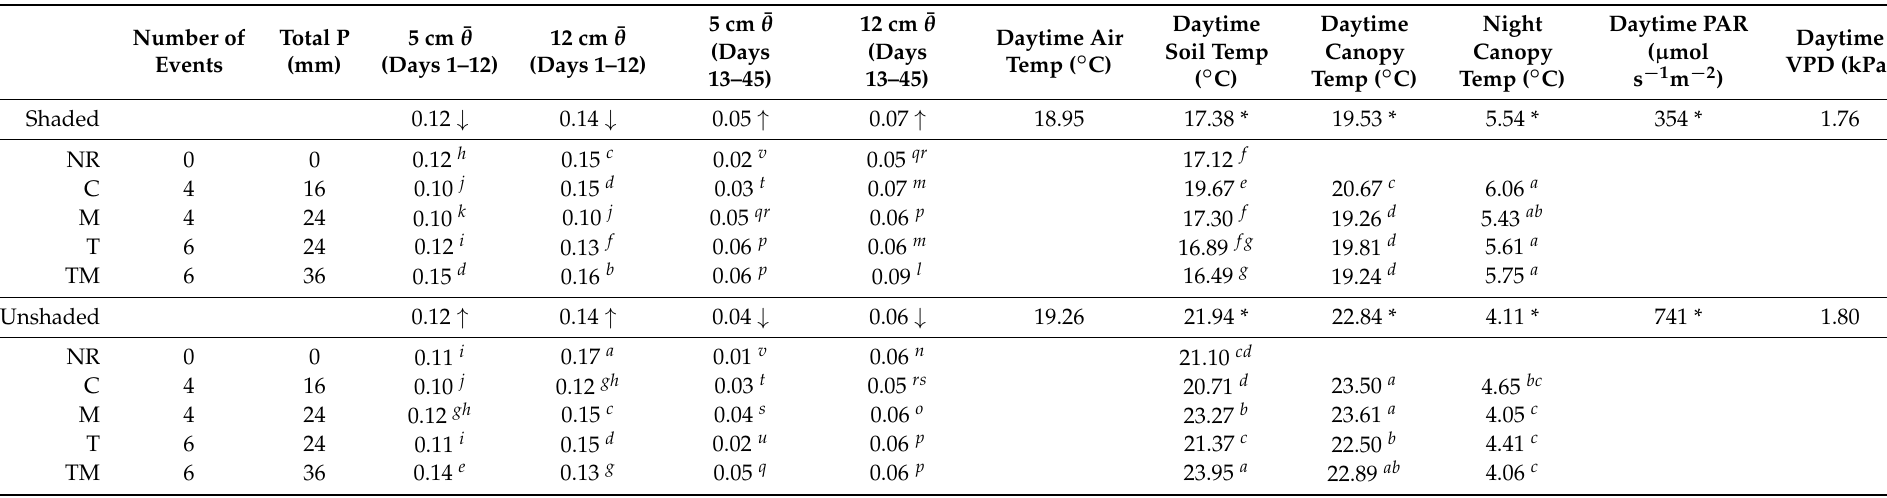
Table 1. Summary of experimental water addition treatments and environmental characteristics of treatment groups (NR: no rain, C: control, M: +50% magnitude, T: +50% timing, TM: +50% timing and magnitude) within microsites (shaded: 47% canopy cover, unshaded: 1% canopy cover). Soil moisture [VWC: mm 3 mm − 3 ] is organized between 5 cm and 12 cm depths and periods of treatment days before (days 1–12) and after (13–45) when VWC began to be depleted (see Figure 3). Because shelter · treatment period VWC differences were significant but very small, arrows indicate which group was significantly higher or lower in each column. Letters indicate statistically significant differences within the 10 shelter-treatment subgroups, and stars indicate statistically significant groupings between sheltered and unsheltered microsites, determined by ANOVA and Tukey’s honest significant differences ( p < 0.05). Daytime values were 8:00–20:00, and nighttime canopy temperature was 4:00–6:00. Significant differences found using Tukey’s honest significant differences ( p < 0.05).